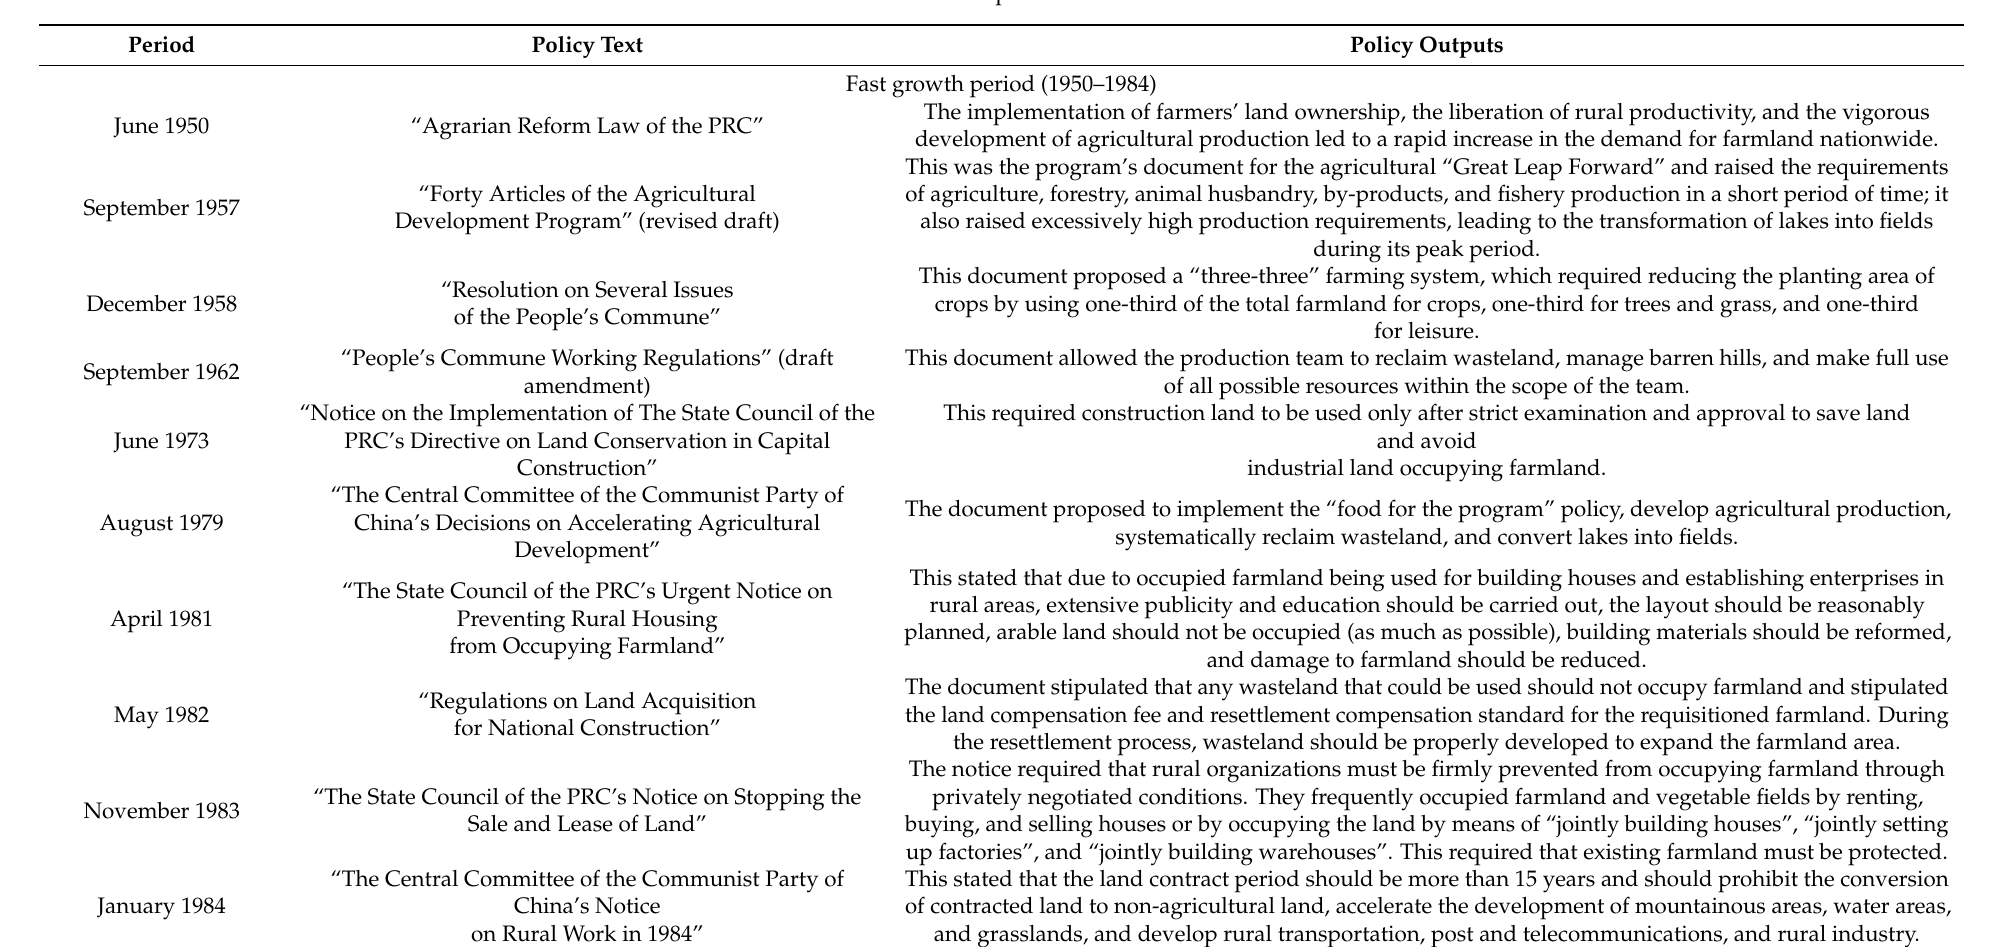
Table A1. Farmland use polies in China over